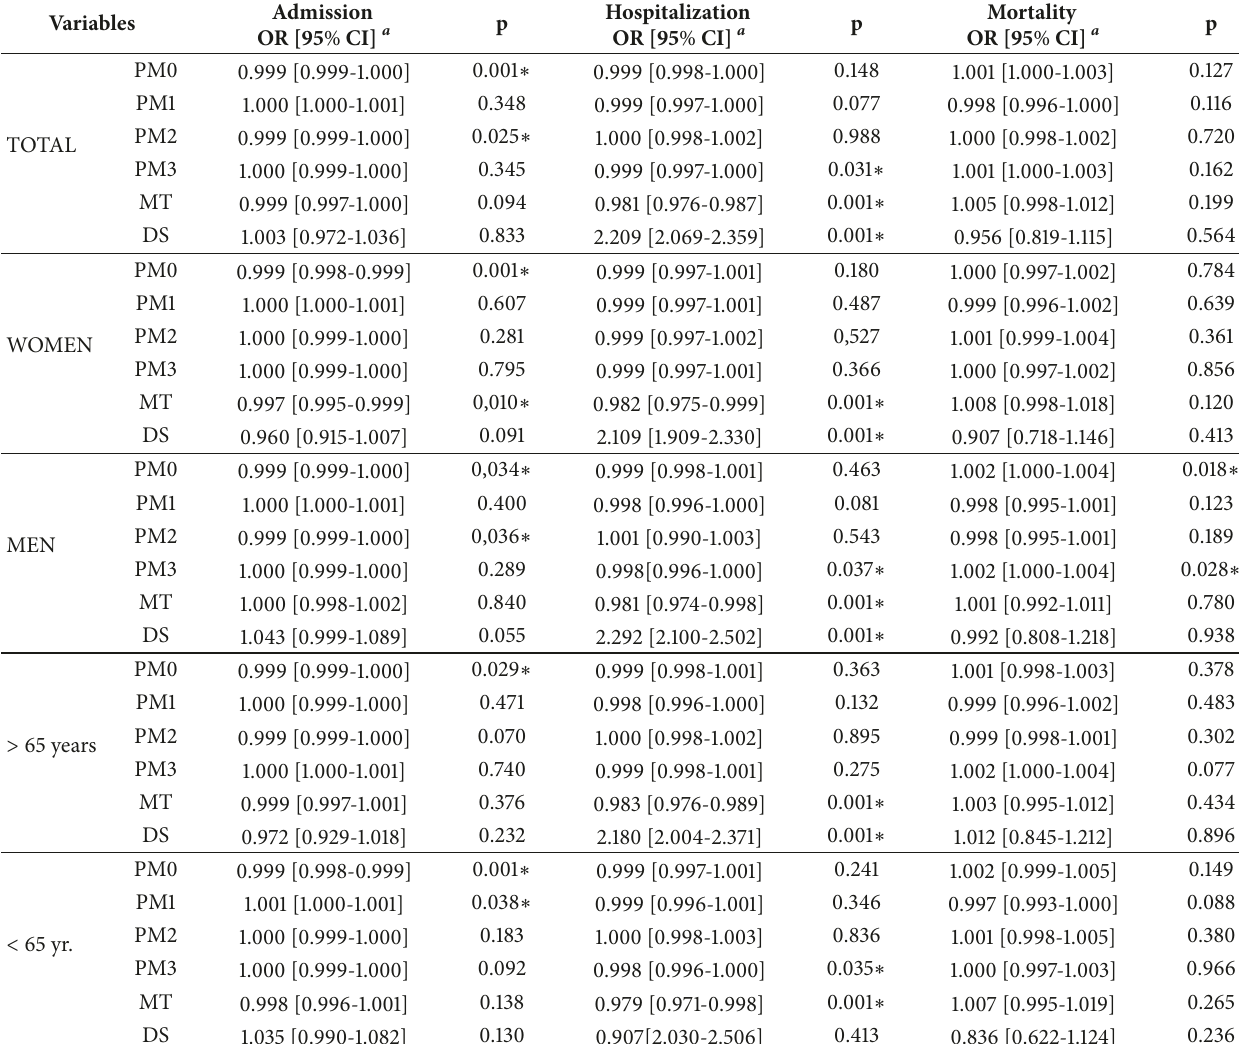
Table 2: Results of generalized additive Poisson models for predicting number of emergency department visits and hospitalization due to